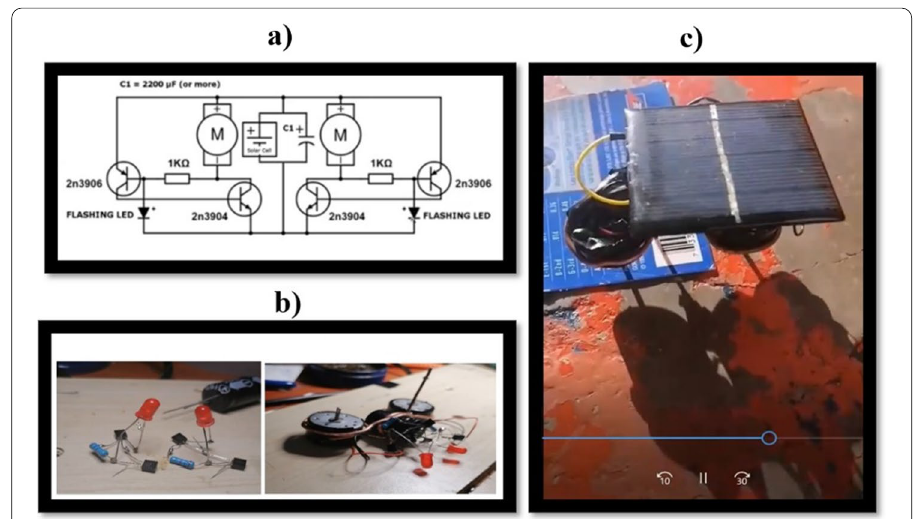
Fig. 13 Images from the video of the “construction of the PHOTOPOPPER robot” activity. a Student explaining how the robot works and associating it with the electronic scheme. b Explanation of the two NVs and their relationship with the motors for movement to the left and the right, respectively. c Explanation of the robot’s operation in an environment with artificial light